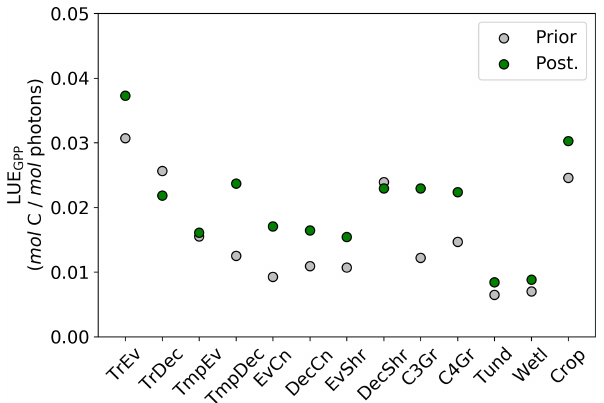
Figure 12. Per PFT LUE GPP for the prior and posterior simula- tions. Values were determined by monthly average GPP divided by monthly averaged APAR, then averaged to annual scales thus aver- aging over seasonal variations. Note that the theoretical maximum is 0.08molCmolphotons − 1 (Waring et al.,